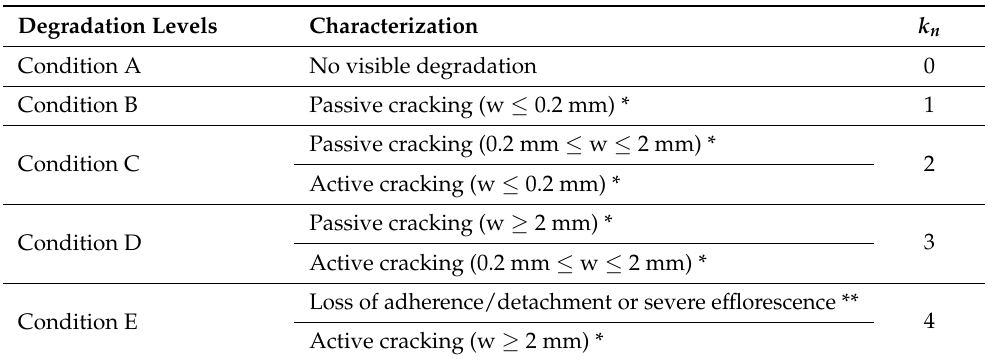
Table 2. Classification of structural anomalies.